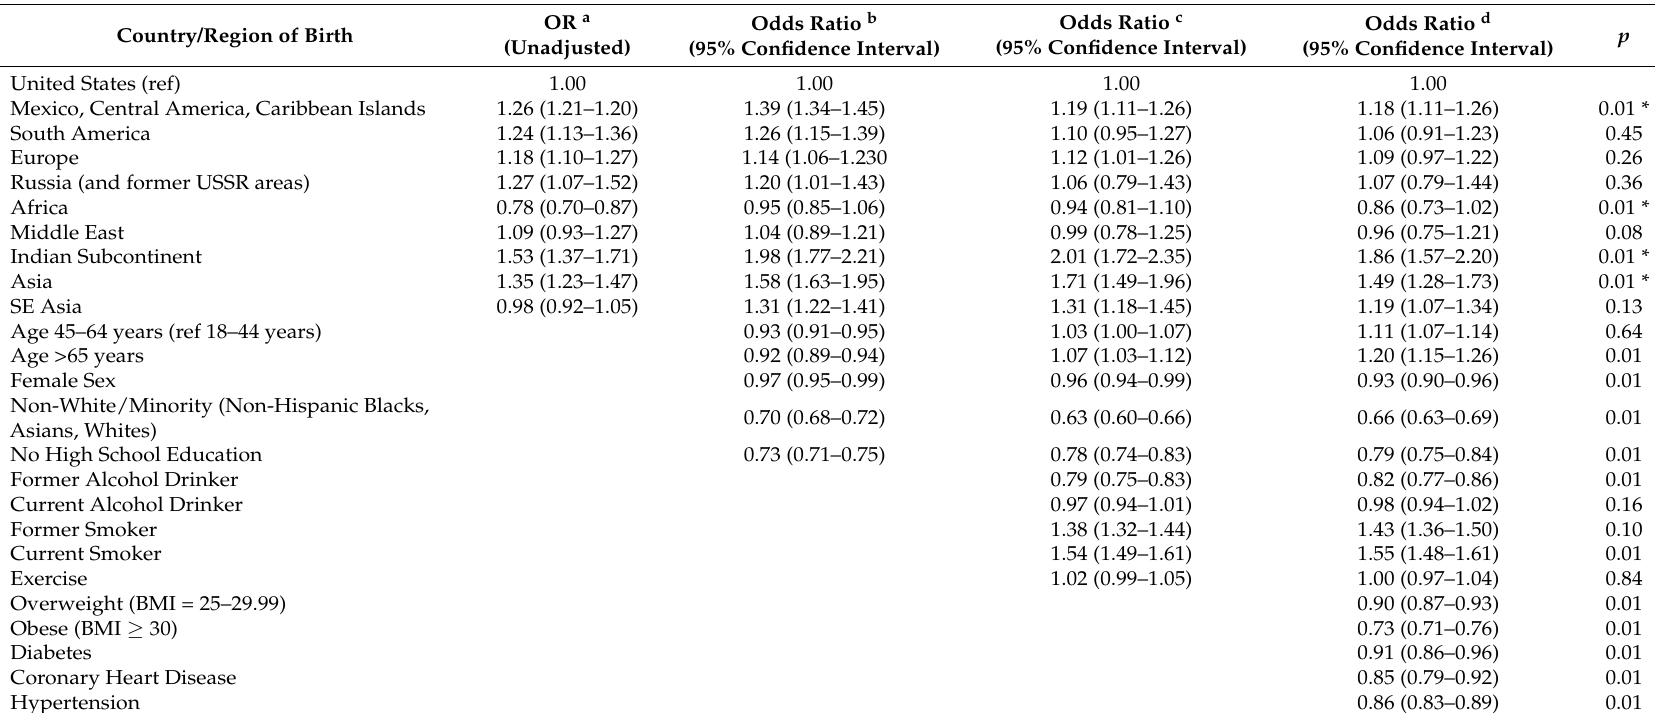
Table 4. Logistic regression for region of birth and healthy sleep (7–8